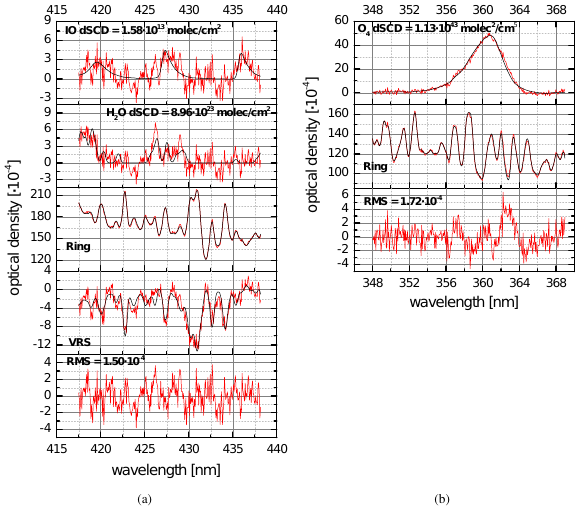
Fig. 1: Example for a spectral retrieval of (a) IO including a VRS compensation spectrum and (b) O 4 . The spectrum was recorded at an elevation angle of 3 ◦ , an SZA of 55.79 ◦ , at 19.87 ◦ N and 147.15 ◦ W and 15:13 local time (UTC + 10 hours) on October 14, 2009. The black lines indicate the fitted absorption cross-sections, whereas the red lines indicate the retrieved spectral signatures. The retrieved absorption structures of NO 2 , O 3 , HCHO , and BrO are not shown.